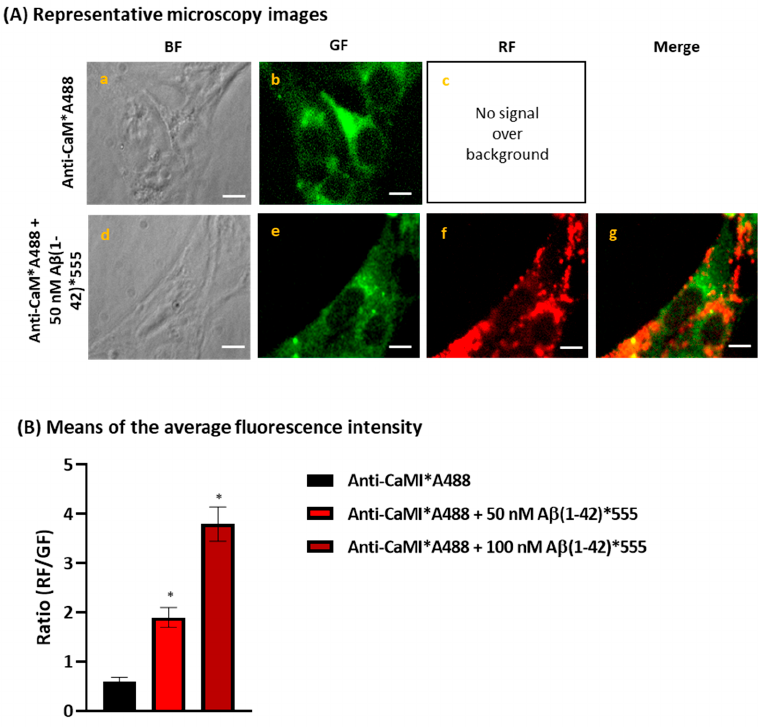
Figure 5. Extensive FRET between CaM and A β (1-42)*555. Panel A : representative fluorescence microscopy images of HT-22 stained with anti-CaM/IgG-Alexa488 (CaM*A488, a – c ) or with anti- CaM/IgG-Alexa488 plus 50 nM A β (1-42)*555 (CaM*A488/A β (1-42)*555, d – g ). BF, GF, and RF images are shown for each of the selected fields, and the orange–yellow areas (merge image, g ) point out for higher intensity FRET pixels. The exposure time for GF and RF images was 0.4 s. Scale bar inserted in fluorescence microscopy images = 20 μ m. Panel B : ratio of red/green fluorescence intensity per pixel (RF/GF) obtained from the analysis of fluorescence intensity data of HT-22 stained with anti-CaM/IgG-Alexa488 only (CaM*A488) and double stained with anti-CaM*IgG-Alexa488 plus 50 or 100 nM of A β (1–42)*555. The results shown are the mean ± SEM (*) p < 0.05 (i.e., statistically significant relative to the control).